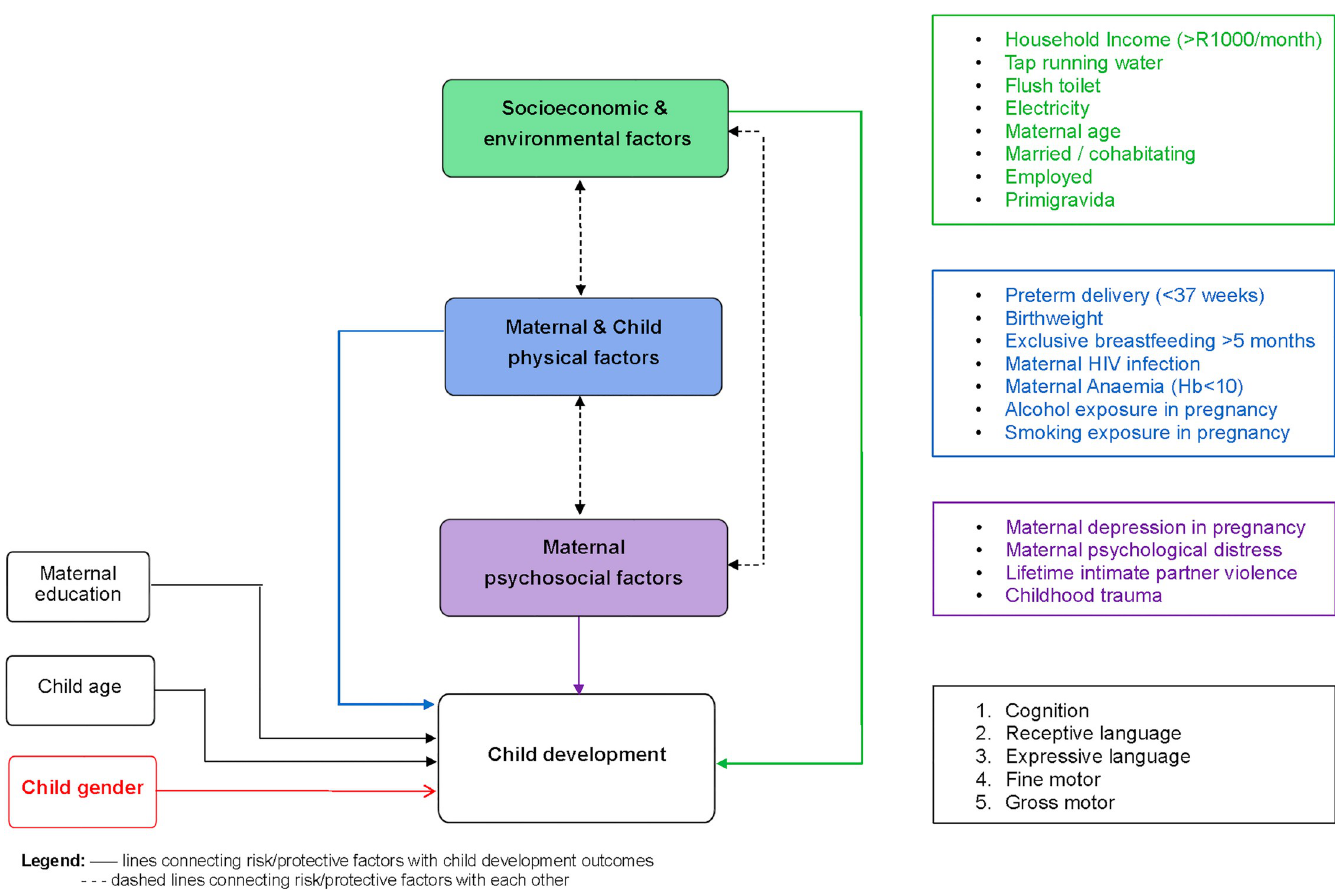
Fig 1. Methodological conceptual framework: Hierarchical model. This was adapted from the model by Chopra and colleagues [36].